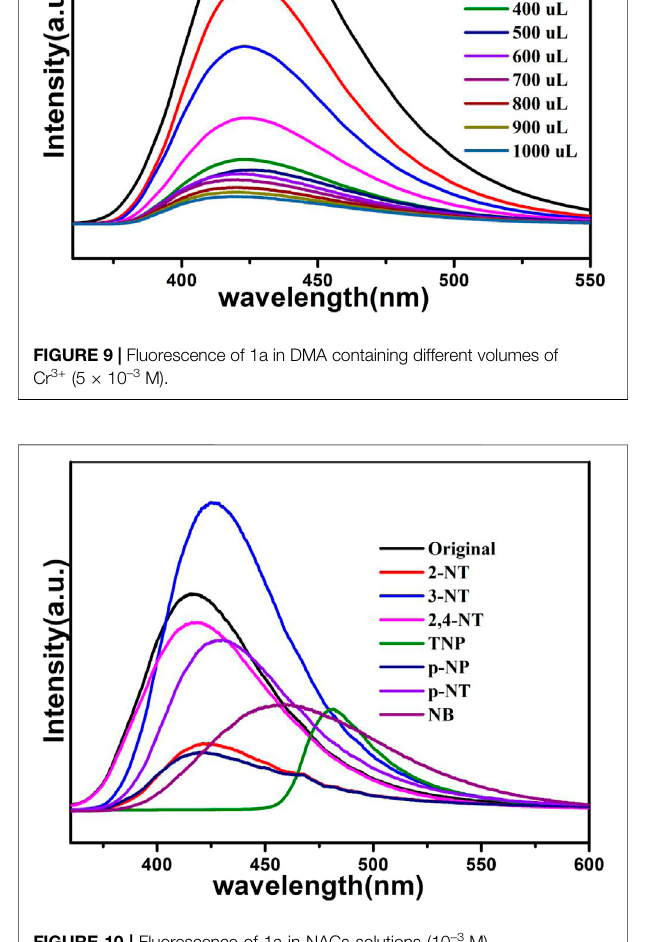
FIGURE 10 | Fluorescence of 1a in NACs solutions (10 – 3 M).